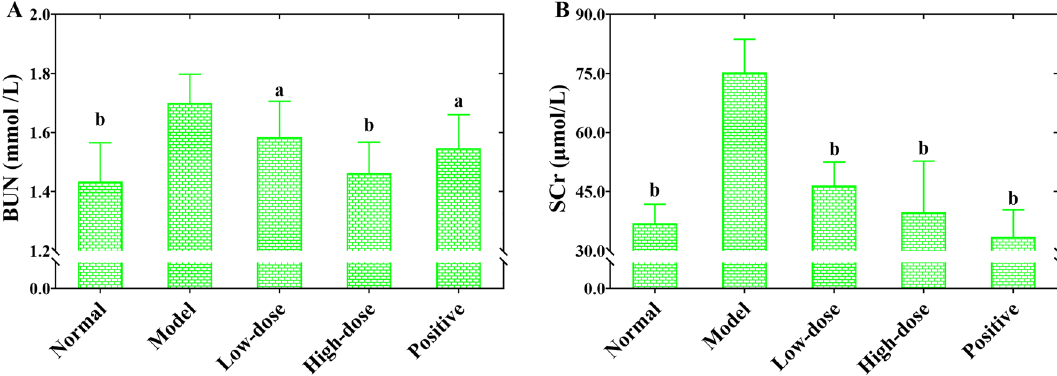
Figure 3. The effects of COS on the content of BUN and SCr in UUO-induced renal fibrosis mice. The concentration BUN of in serum ( A ). The concentration of SCr in serum ( B